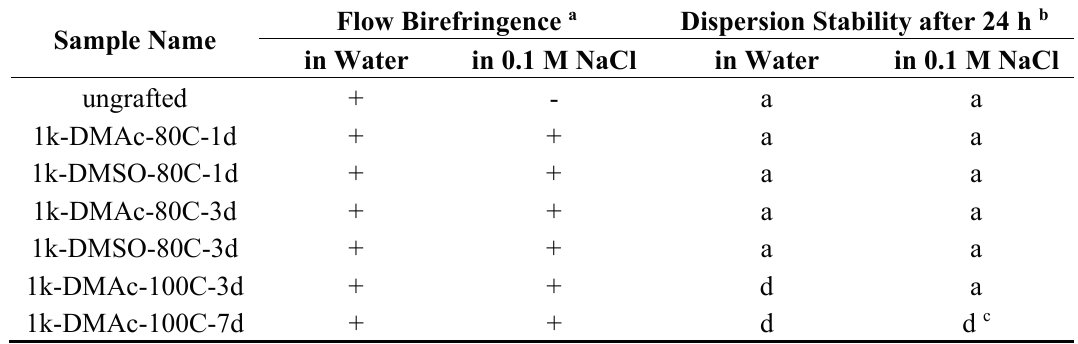
Table 1. Qualitative observation of flow birefringence and sedimentation for ungrafted material and mPEG-grafted nanowshiker suspensions prepared under various